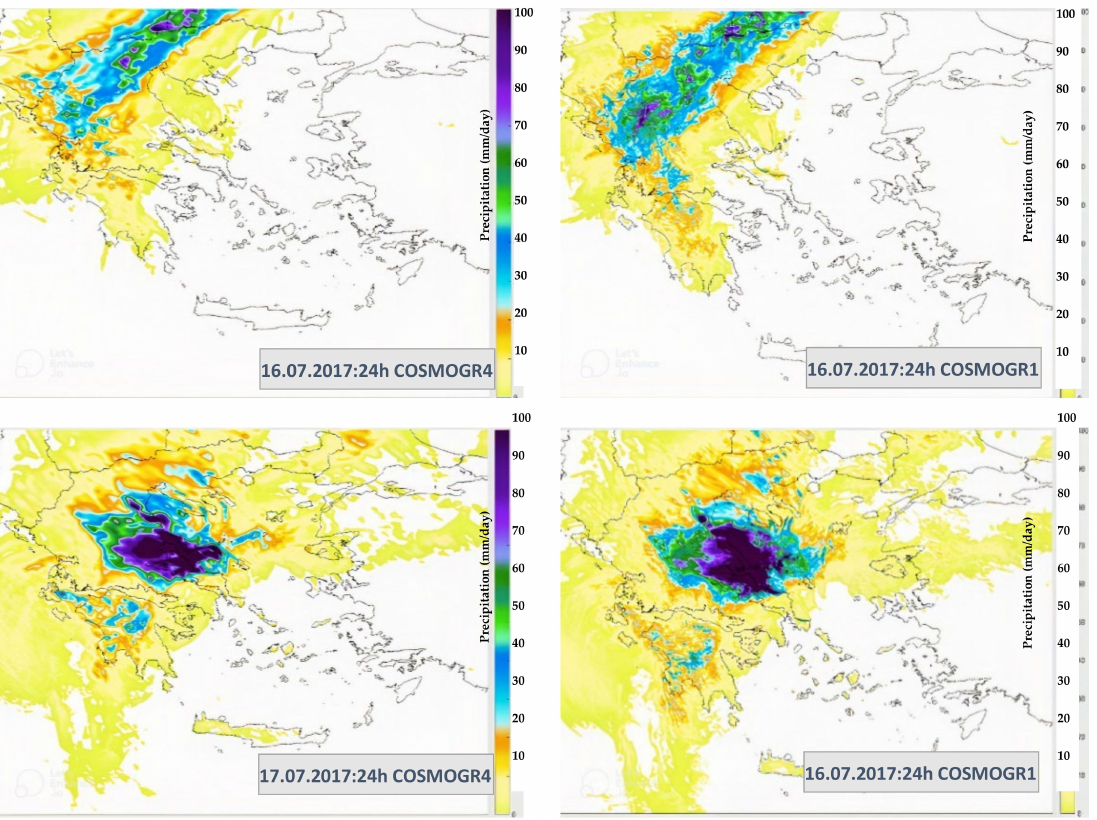
Figure 8. 24-h precipitation forecasts for 16–17 July 2017 with COSMOGR4 ( left ) and COSMOGR1 ( right ). Precipitation color range: <10 mm/day—light yellow to 100 mm/day—dark